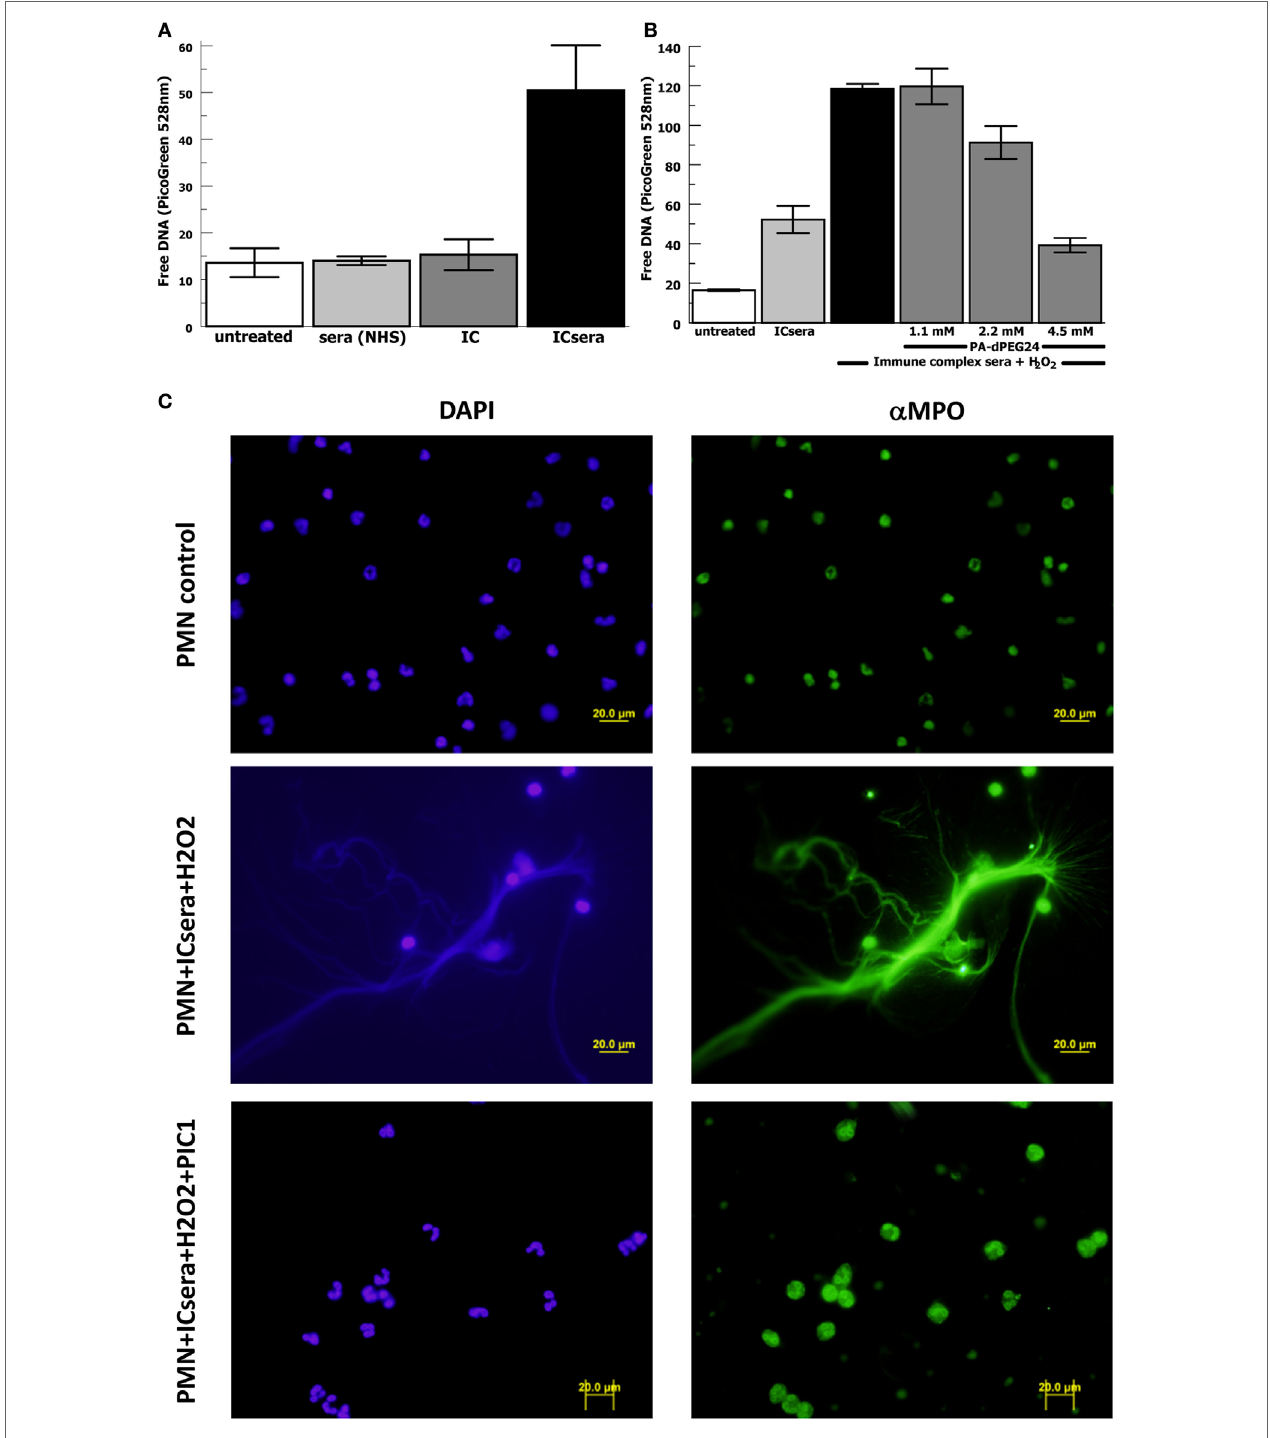
FigUre 7 | PA-dPEG24 inhibition of immune complex-activated serum-initiated neutrophil extracellular trap (NET) formation with human neutrophils (PMN) assayed by fluorescence microscopy and PicoGreen quantitation of free DNA. Ovalbumin–antiovalbumin immune complexes (IC) were utilized. (a) NET formation induced by PMNs incubated alone (untreated), with normal human sera (NHS), IC alone (IC), or immune-complex-activated human sera (ICsera). Data are means of ( n = 5) independent experiments ± SEM. (B) PA-dPEG24 inhibition of NET generation by human neutrophils stimulated with ICsera assayed by PicoGreen. Data are means of ( n = 4) independent experiments ± SEM. (c) The first row shows unstimulated neutrophils, the second row shows neutrophils stimulated with ICsera and hydrogen peroxide (H 2 O 2 ), and the third row shows neutrophils stimulated with ICsera + H 2 O 2 in the presence of PA-dPEG24 (peptide inhibitor of complement C1). The first column is slides probed with DAPI to visualize DNA and the second column is slides probed with anti-MPO antibody.